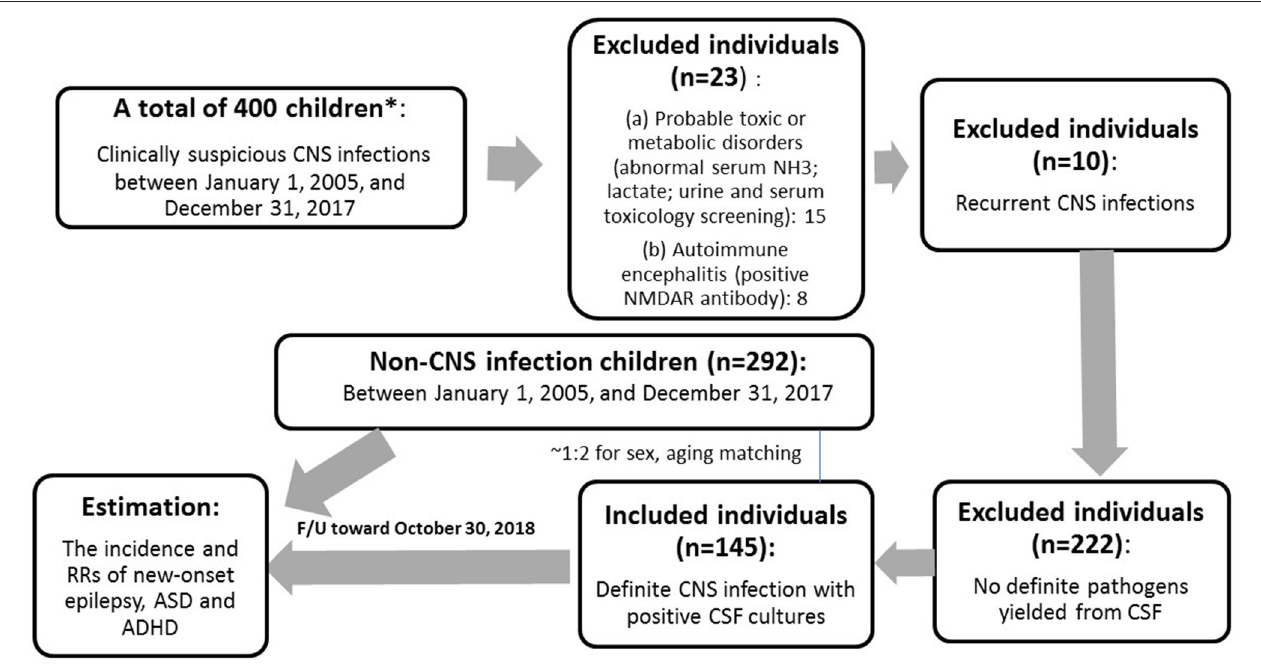
FIGURE 1 | Flowchart of the study. *The patients who were screened from the medical records and contacted by the our case